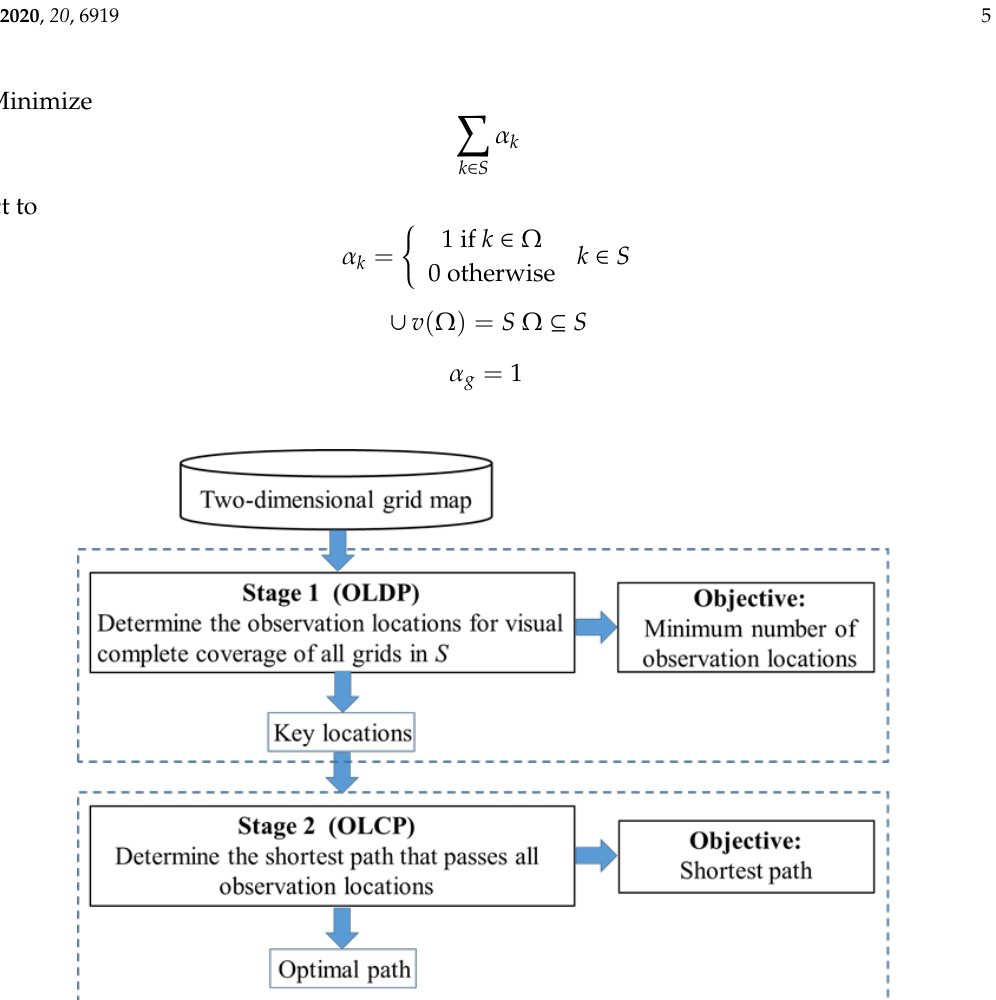
Figure 3. The diagram of the two-stage optimization program.